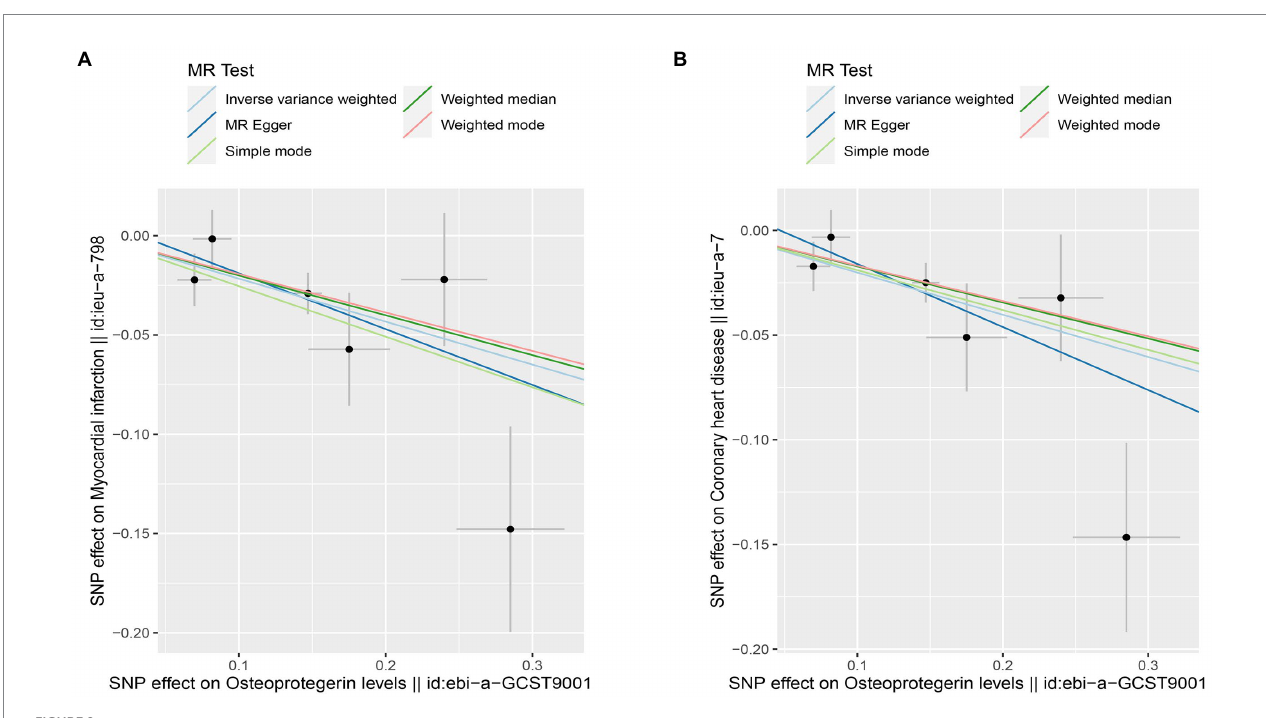
FIGURE 9 Scatterplot of MR estimates of genetic risk of OPG on AMI and CHD after removing rs1385492. Scatter-plot of genetic effects on OPG versus their effects on AMI (A) and CHD (B) with corresponding standard errors denoted by horizontal and vertical lines. The slope of each line corresponds to the estimated MR effect from different methods.